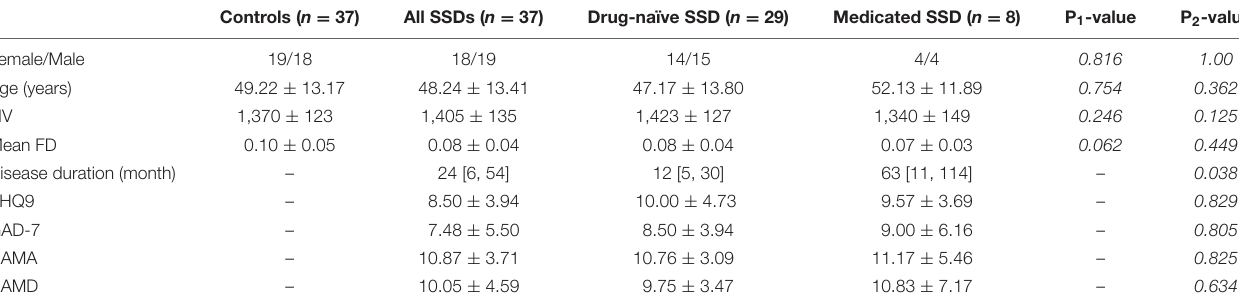
TABLE 1 | Demographic characteristics and clinical scores of the SSD group and control